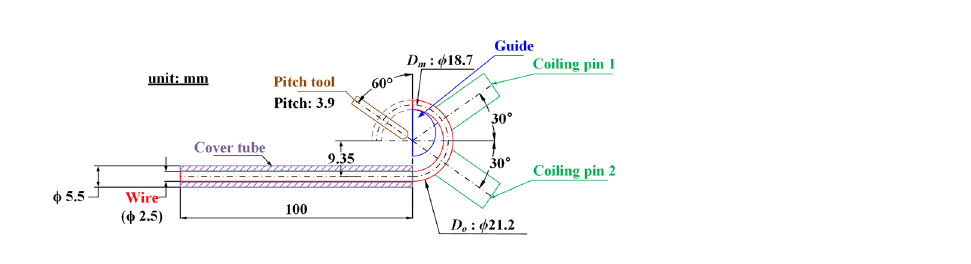
Figure 10. Schematic illustrating the cold coiling